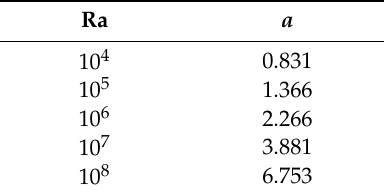
Table 1. Lists the correlation constant a for R in =